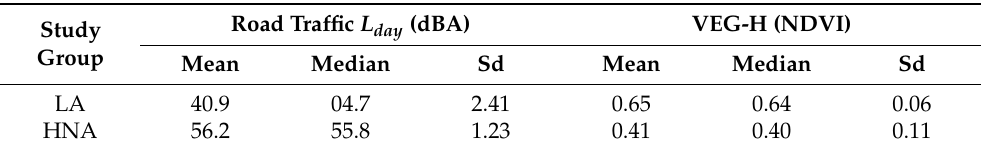
Table 4. Road traffic noise exposure ( L day ) and VEG-H (NDVI) at home of the participants (50 m buffer) of the groups Low noise exposure at home with Access to GSs (LA) and High noise exposure at home with No access to GSs (HNA).